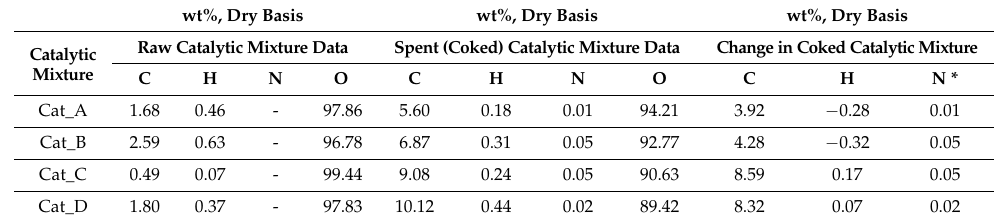
Table 4. Elemental analysis of the raw and spent catalytic mixtures and wt% change in coke (coke spent cat −coke raw cat ).